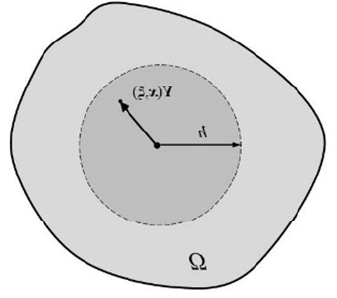
Figure 3. Integration around the calculation point.